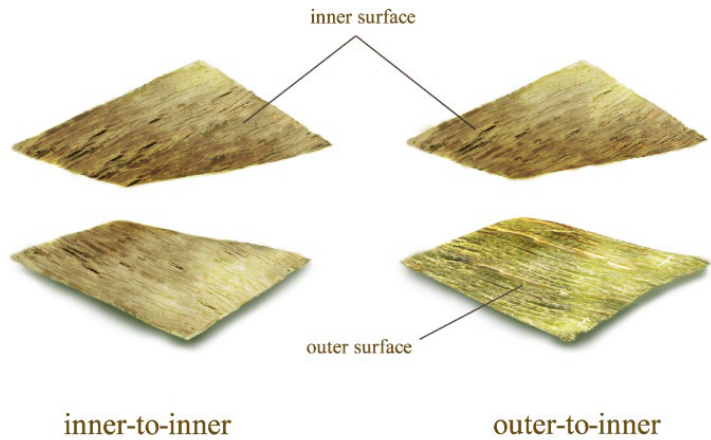
Figure 6. Two BSC assembly patterns.